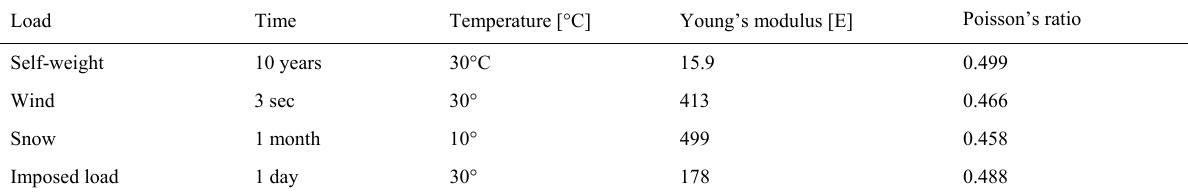
Table 5: Value of the Young’s modulus of the SG